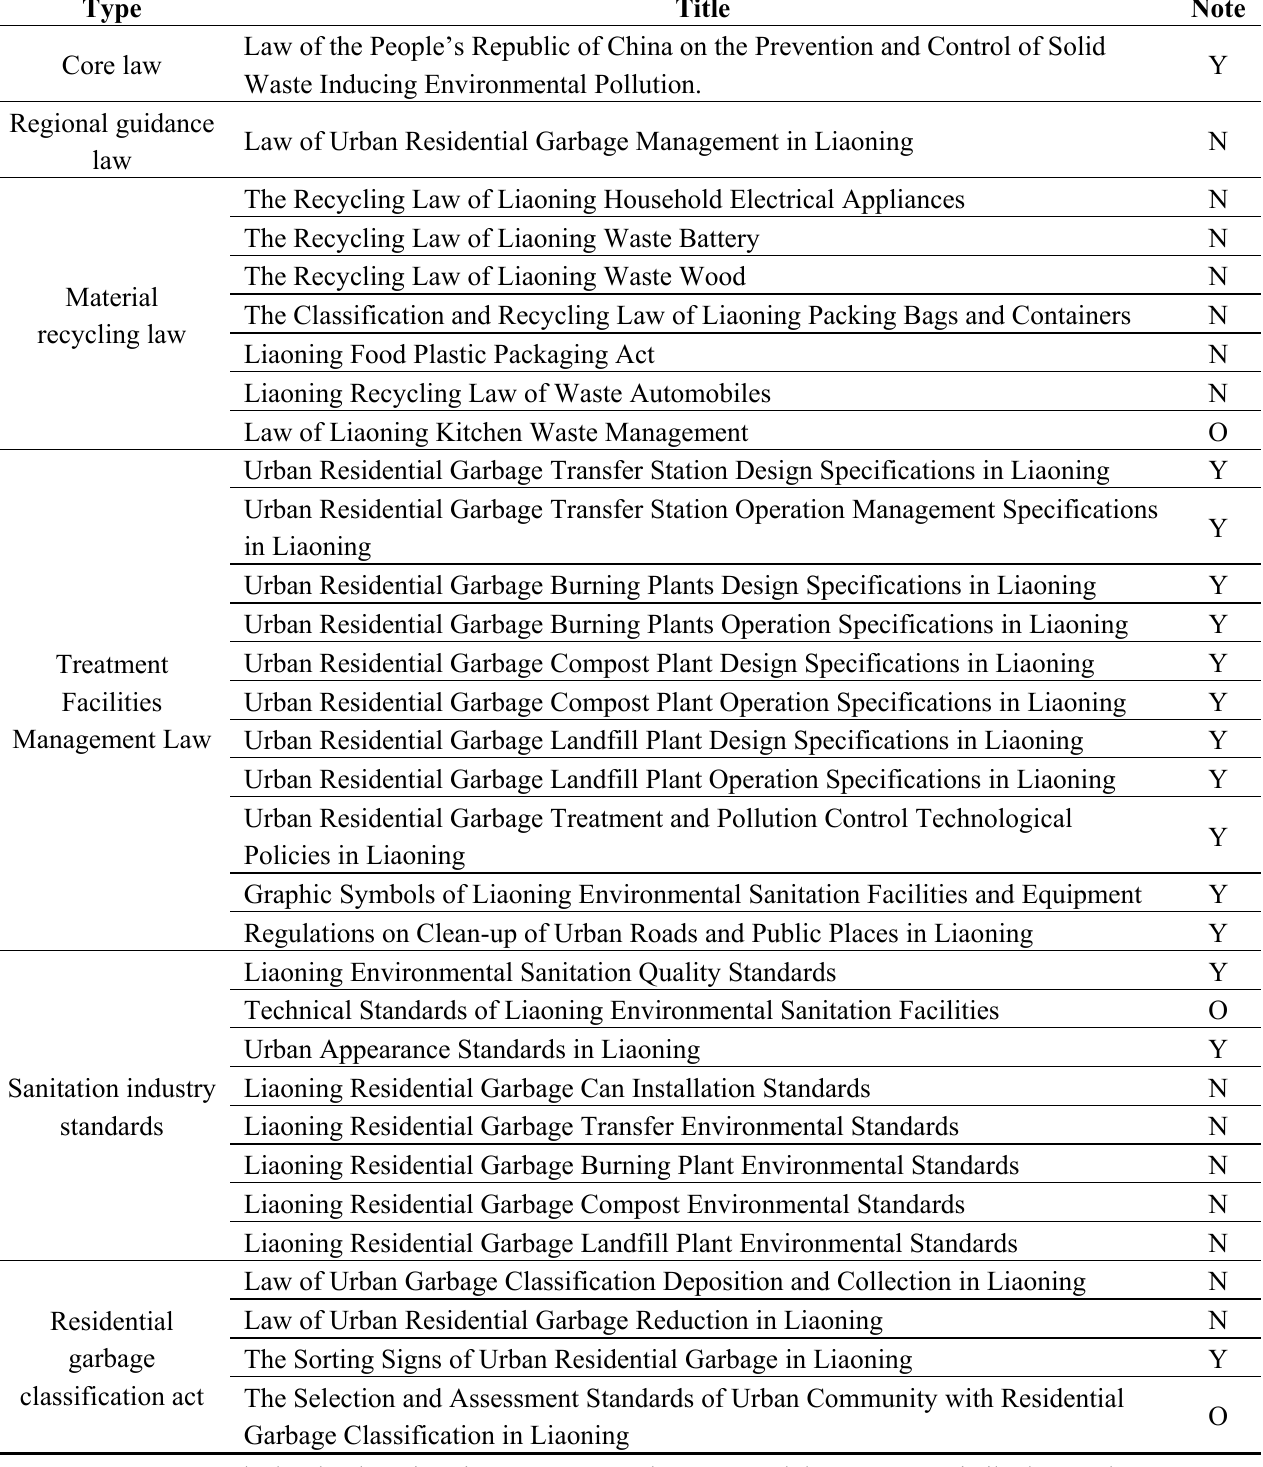
Table 8. The recommended legal framework of the residential garbage management in